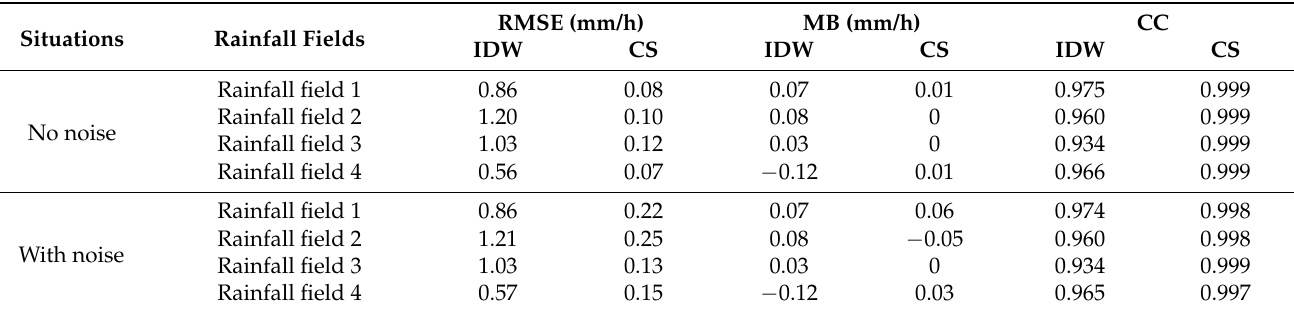
Table 1. The quantitative results of reconstructing the rainfall fields of the rainfall event by ESL network